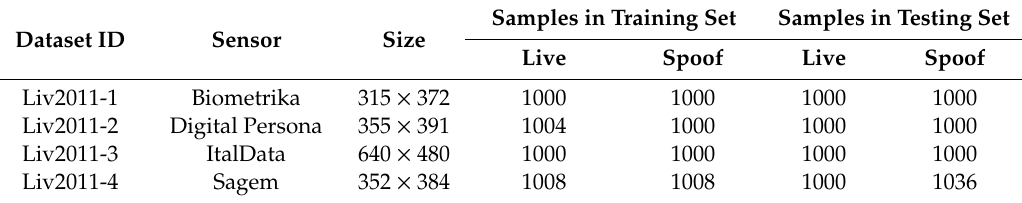
Table 2. The image distribution of the LivDet 2011 dataset.